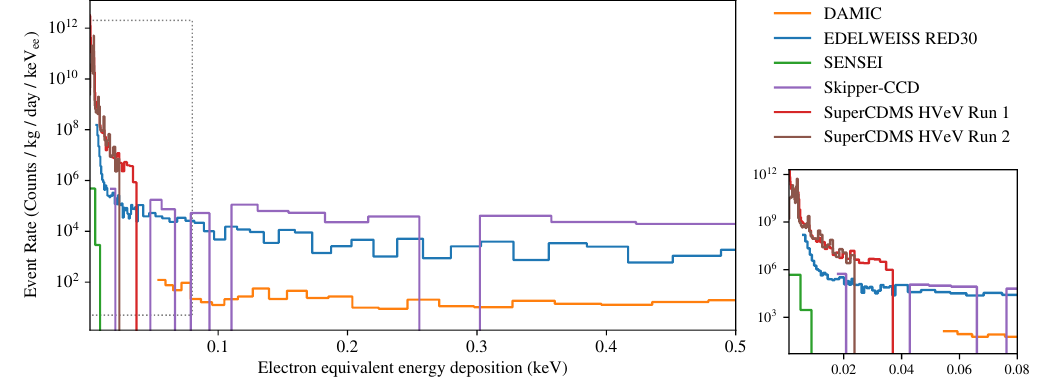
Figure 20: (a, b) (left, large) Energy spectra of excess observations from the indi- vidual experiments . In all energy spectra, the rise at low energies is visible. (right, small) Zoom into the excess region of the spectrum [ 15 ]